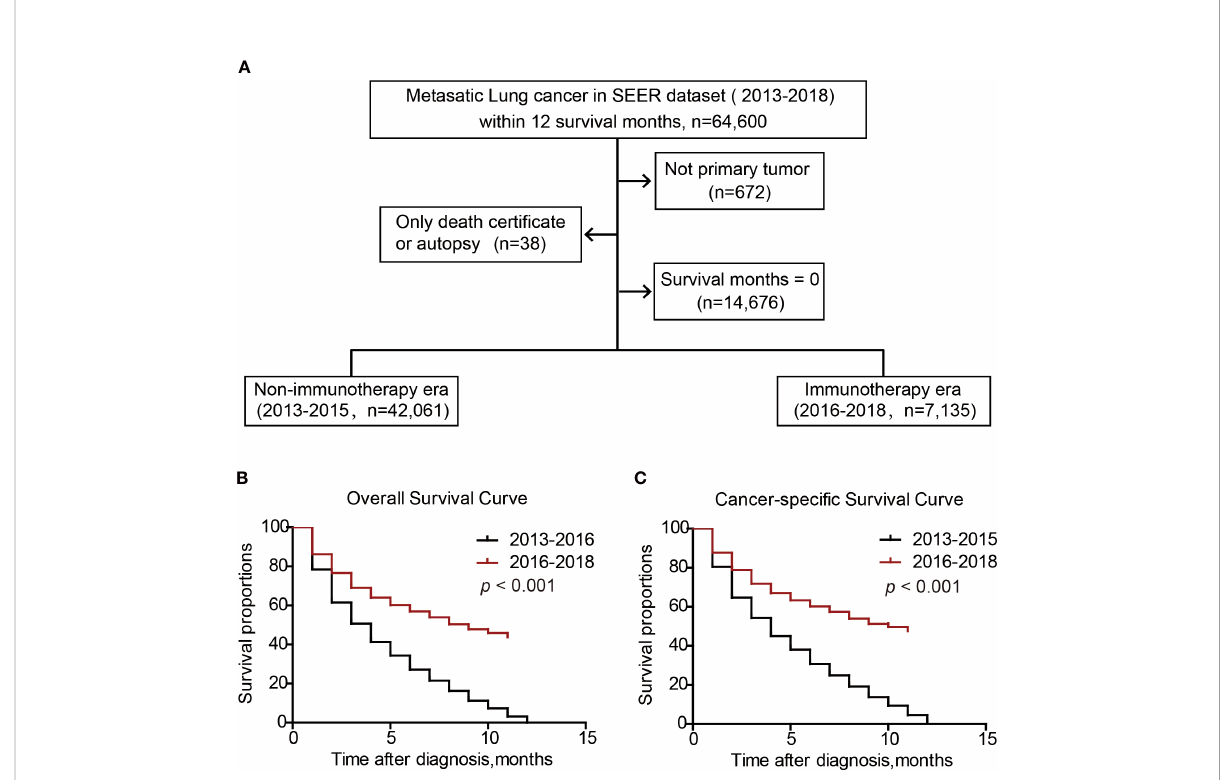
FIGURE 7 Survival bene fi ts of metastatic lung cancer patients in immunotherapeutic era. Patients inclusion and exclusion fl ow (A) . Overall survival (B) and cancer-speci fi c survival (C) of metastatic lung cancer